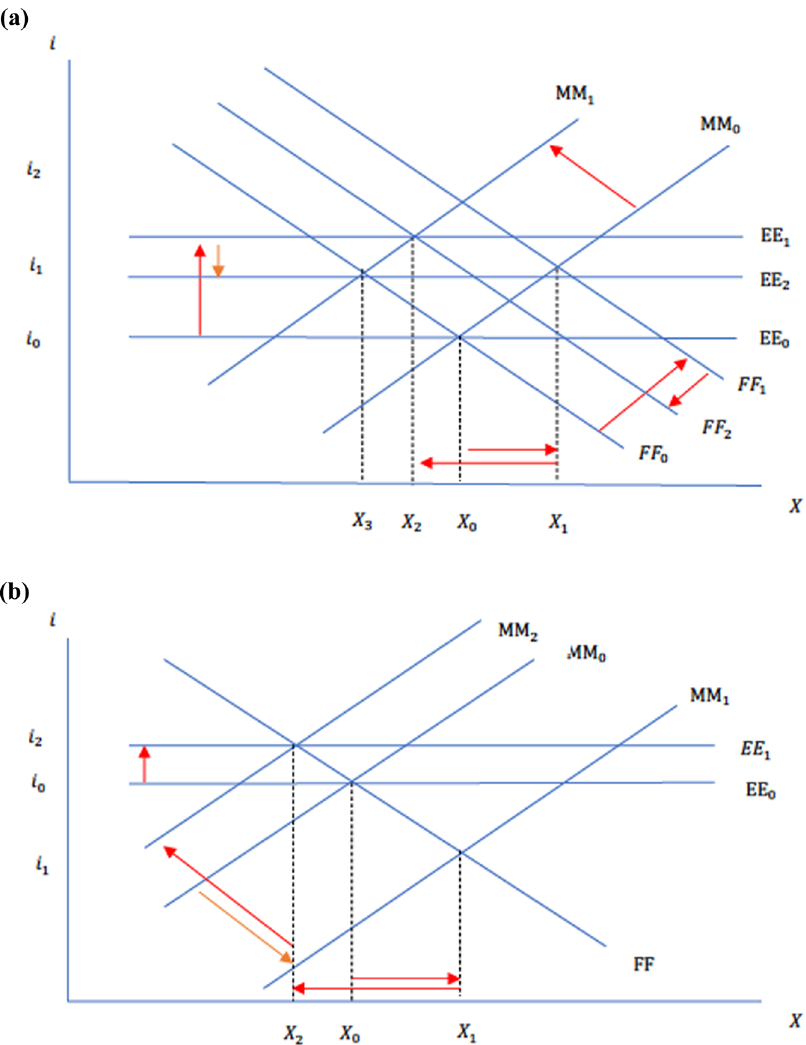
Figure 1: ( a ) Fiscal Impulse and ( b ) Momentary Impulse. Note: Figure 1a and b: The curve MM is the locus of ( i, X ) pairs at which b ∆ 0 = ; the curve FF is the locus of ( i, X ) pairs at which m ∆ 0 = ; and the schedule EE is the locus of ( i, X ) pairs at which the real exchange rate does not ( ) = . Figure 1a portrays the case where the expansionary fi scal stimulus b ∆ 0 > is over - compensated by the e ff ects of the drop change ∆ 0 e P in the level of policy credibility as perceived by the market. The fi scal authorities initially shift the FF schedule rightward from FF 0 to FF 1 to a higher level of output, which is only partially dampened by a higher interest rate. However, the lack of credibility causes investors to sell o ff domestic bonds in exchange for foreign assets, and the monetary and fi scal authorities to adjust, respectively, the money and bond supply to keep balance in the bond and foreign exchange markets. As a result, the EE and MM schedules shift, respectively, from EE 0 up to EE 1 and from MM 0 backward to MM , 1 and the FF schedule moves somewhat backward to FF 2 , all crossing each other at an interest rate that over - compensated the initial stimulus. As noted in the text, the adjustment process might be such as to eventually lead to an appreciation of the exchange rate, lower output, and lower in fl ation, with the schedule EE shifting backward to EE 2 . Figure 1b represents the case where the expansionary output e ff ect of the monetary impulse m ∆ 0 > is more o ff set by the e ff ects of the drop in the level of policy credibility as perceived by the market. The monetary policy authorities initially shift the MM schedule from MM 0 to MM 1 to a lower interest and exchange rate levels. The lack of credibility, however, causes investors to sell domestic bonds for foreign assets, causing the interest rate to rise and the currency to weaken. The EE schedule shifts upward from EE 0 to EE 1 and the monetary authorities must shrink the money supply as necessary to restore equilibrium in the bond and foreign exchange markets. As a result, the adjustment might be such as to even over - compensated the initial